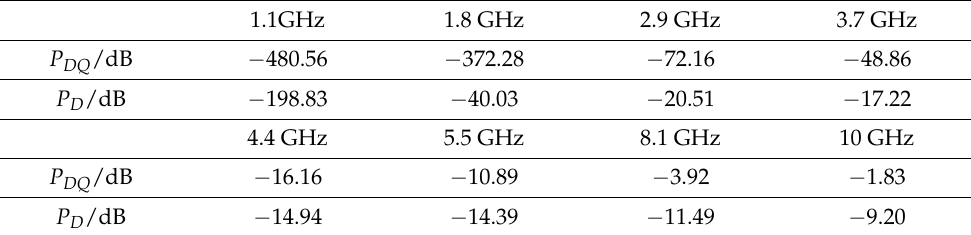
Table 3. The average detection probability of the quantum radar and the conventional radar at different